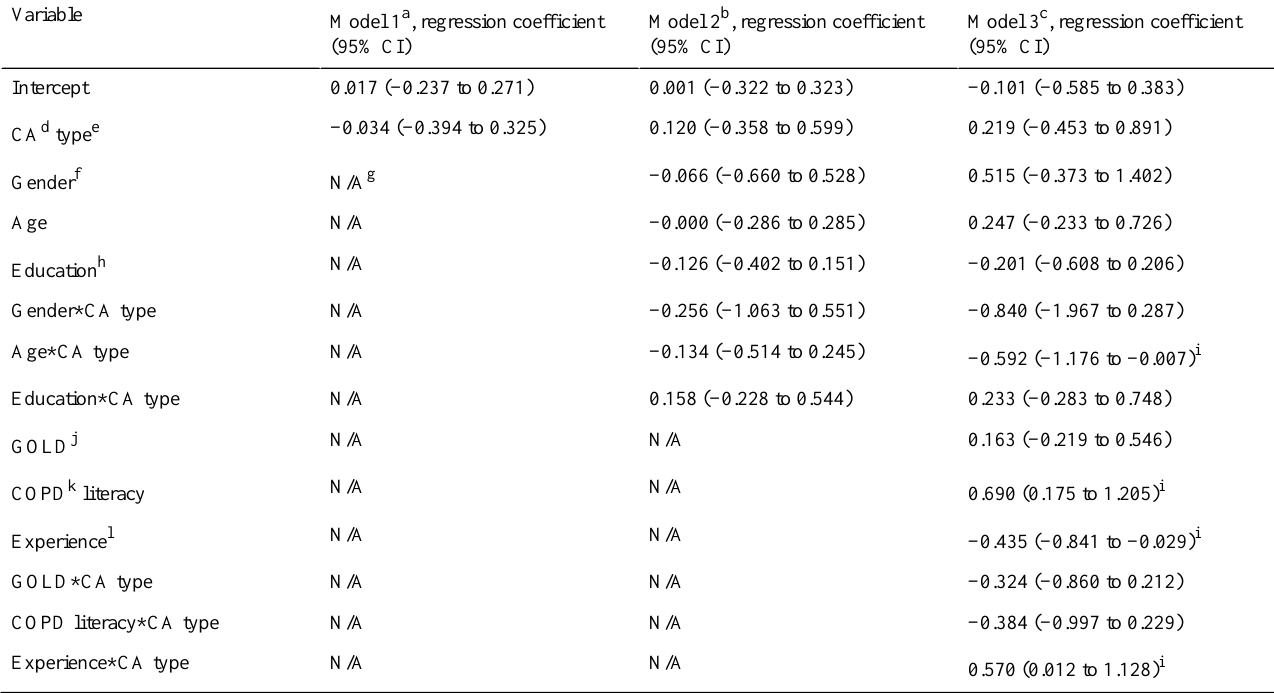
Table 11. Regression of conversational agent type, participants’ demographics, and chronic obstructive pulmonary disease–related characteristics in terms of participants’working alliance (goal agreement) with the conversational